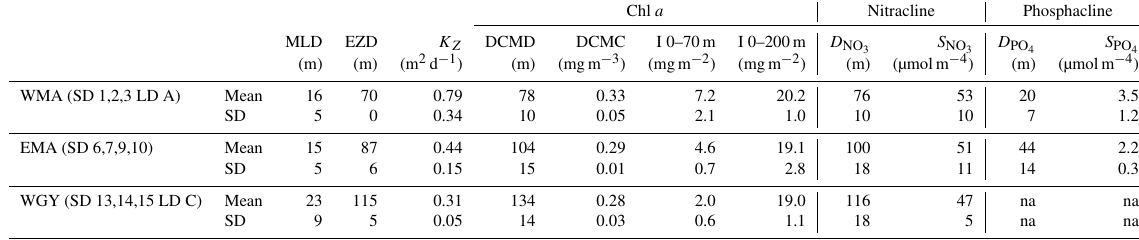
Table 2. General physical and biogeochemical characteristics for the three selected areas presented in columns: (1) western Melanesian Archipelago (WMA), eastern Melanesian Archipelago (EMA), and western gyre (WGY) with the corresponding stations chosen; (2) mean or standard deviation (SD); (3) MLD: mixed layer depth (m); (4) EZD: euphotic zone depth (m); (5) K z : mean 40–200m vertical